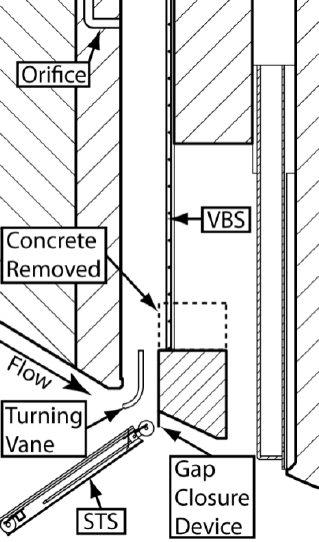
Figure 2. Cross-section view of a gate well slot of B2 intakes. The submerged traveling screen (STS) guides fish from the primary turbine intake flow into the gate well and subsequently into the JBS through the